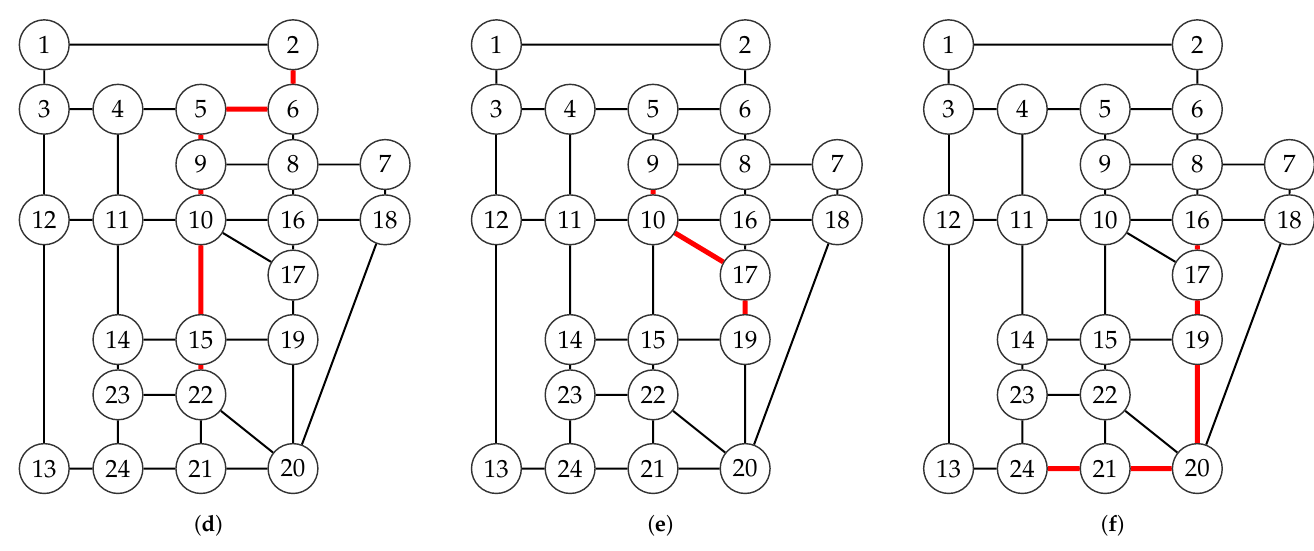
Figure 3. Optimal routes for six different OD pairs with parameters of (0.3, 0.3, 0.3). ( a ) Optimal route of OD pair (7, 24), ( b ) Optimal route of OD pair (1, 20), ( c ) Optimal route of OD pair (1, 19), ( d ) Optimal route of OD pair (2, 22), ( e ) Optimal route of OD pair (9, 19), ( f ) Optimal route of OD pair (16,